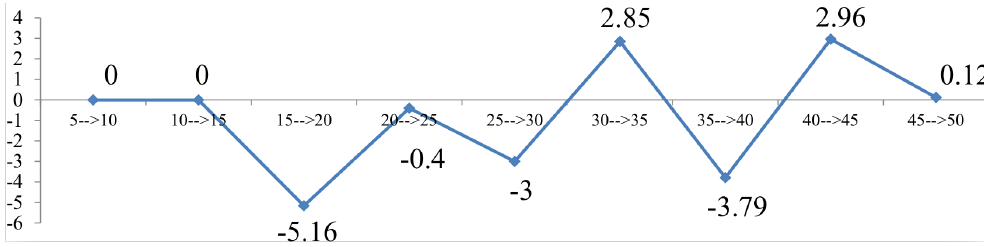
Figure 12. The relative differences in accuracy with increasing number of authors.